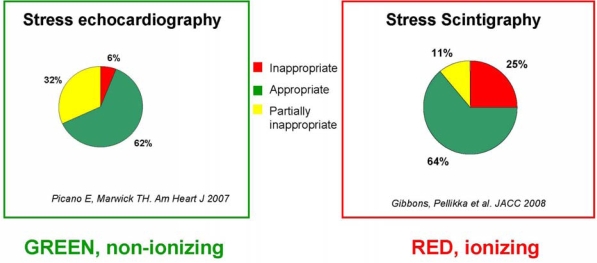
Inappropriateness in stress echocardiography (left) and cardiac stress imaging (right). Data are derived from [5] (Pisa and Brisbane echo labs in Italy and Australia) and [6] (Mayo Clinic nuclear cardiology lab in the USA).